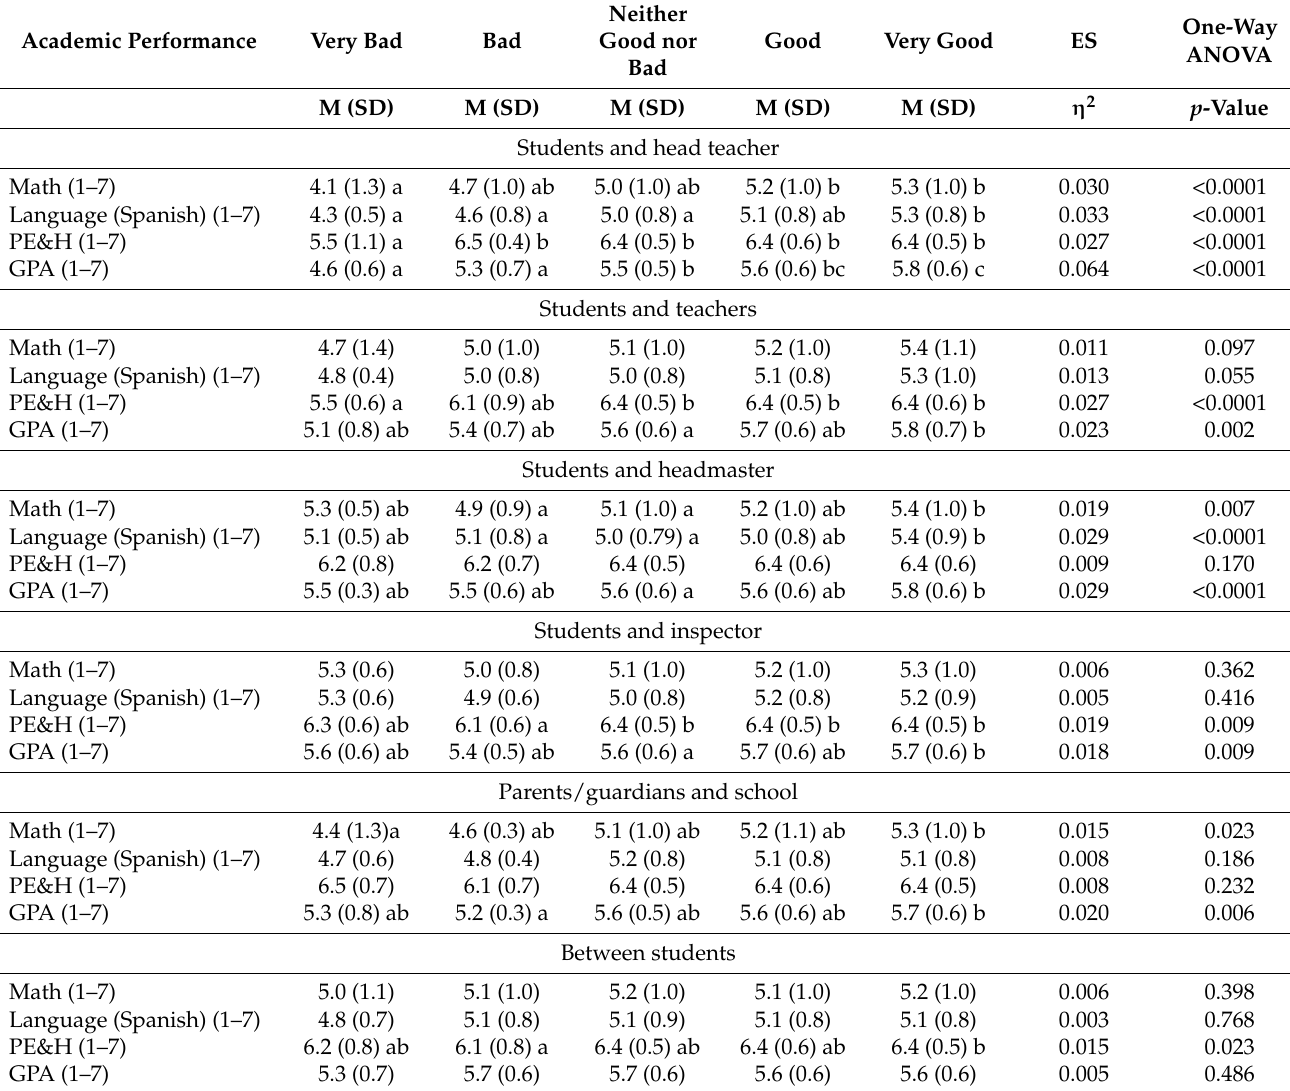
Table 3. AFG and GPAs according to the quality of the interpersonal relationships between school